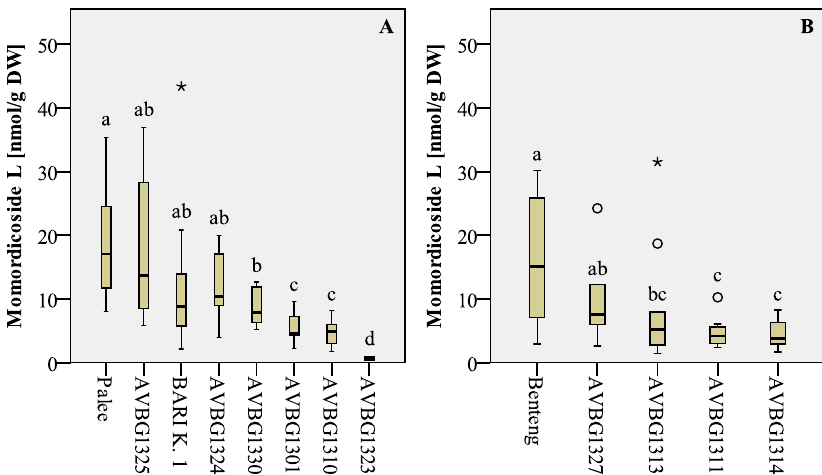
Fig. 3: Momordicoside L contents of eight South Asian (A) and five Southeast Asian (B) type bitter gourd entries cultivated in a greenhouse in Karlsruhe, Germany. Stars stand for extreme values, open circles for outliers. Extreme values and outliers were also included in statistical analyses. BARI K. 1 = ‘BARI Karella 1’, DW = dry weight. Plots with same letters are not significant different (P > 0.05). Means of 10 fruits per